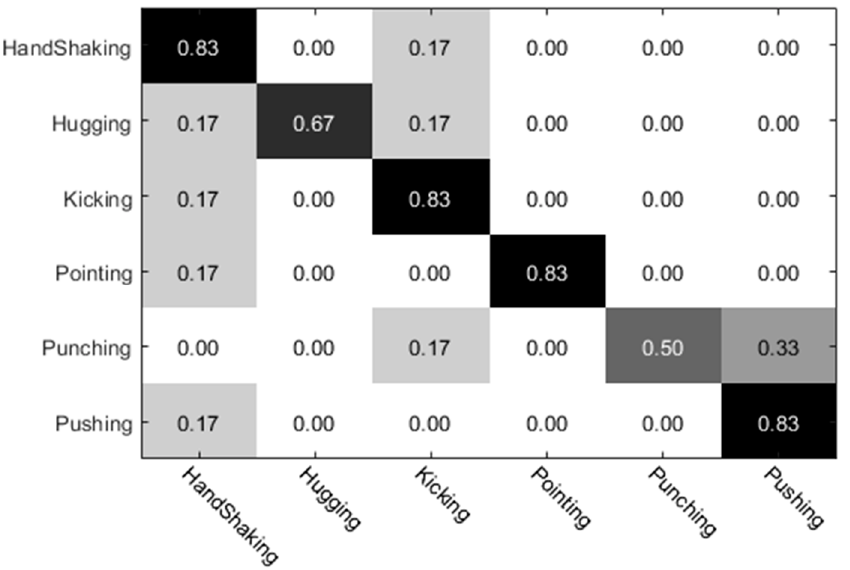
Figure 11. Individual video (right) classification results.